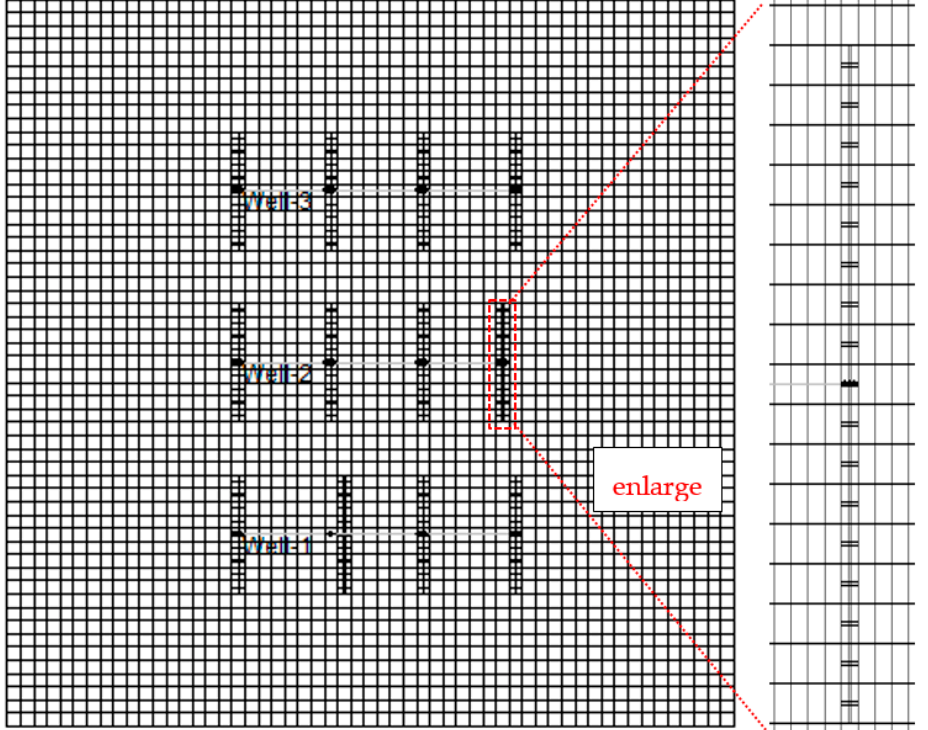
Figure 9. Top view of the numerical model of Case II in the CMG-GEM module.